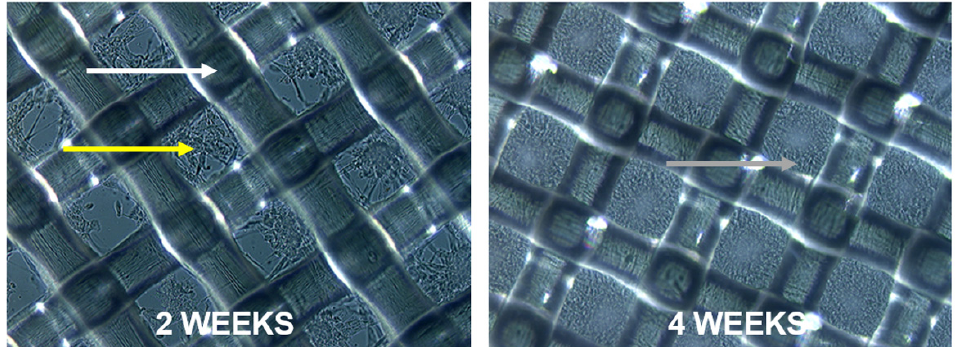
Figure 2. Organotypic 3D dermal model. Phase contrast photomicrograph (100X) of 3D dermal model after two and four weeks in culture (white arrow: woven nylon scaffold; yellow arrow: dermal fibroblasts depositing an immature extracellular matrix; gray arrow: extracellular matrix deposited by dermal fibroblasts). After seeding to nylon scaffolding, dermal fibroblasts were cultured for approximately eight weeks until a mature dermal extracellular matrix formed; the nylon provides a meshwork with pores which are conducive to the deposition and maturation of a structurally complete 3D extracellular matrix. This relatively lengthy timeframe allows for the development and maturation of a dermal-equivalent with organotypic properties that closely resemble skin [13 − 15]; therefore, the effects of racemic equol could be tested in an environment that closely resembles the intact dermis.